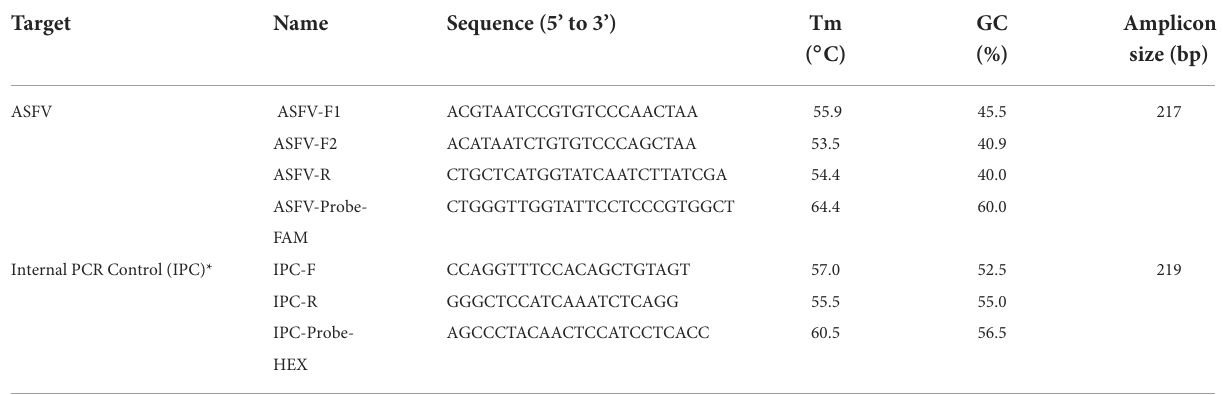
TABLE 2 Sequence of primers and probes used in this